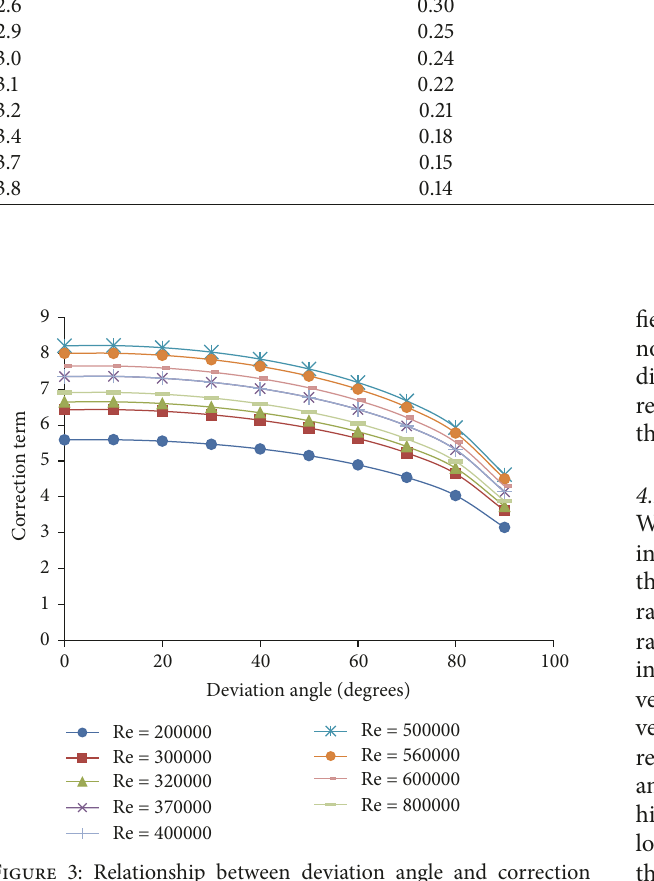
Figure 3: Relationship between deviation angle and correction coefficient under different Reynolds